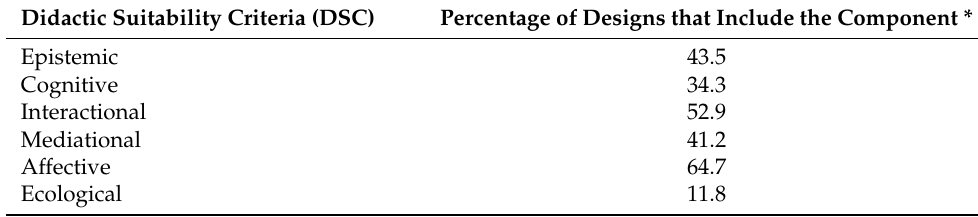
Table 6. Percentage of designs considering each of the DSC components. Didactic Suitability Criteria (DSC) Percentage of Designs that Include the Component * Epistemic 43.5 Cognitive 34.3 Interactional 52.9 Mediational 41.2 Affective 64.7